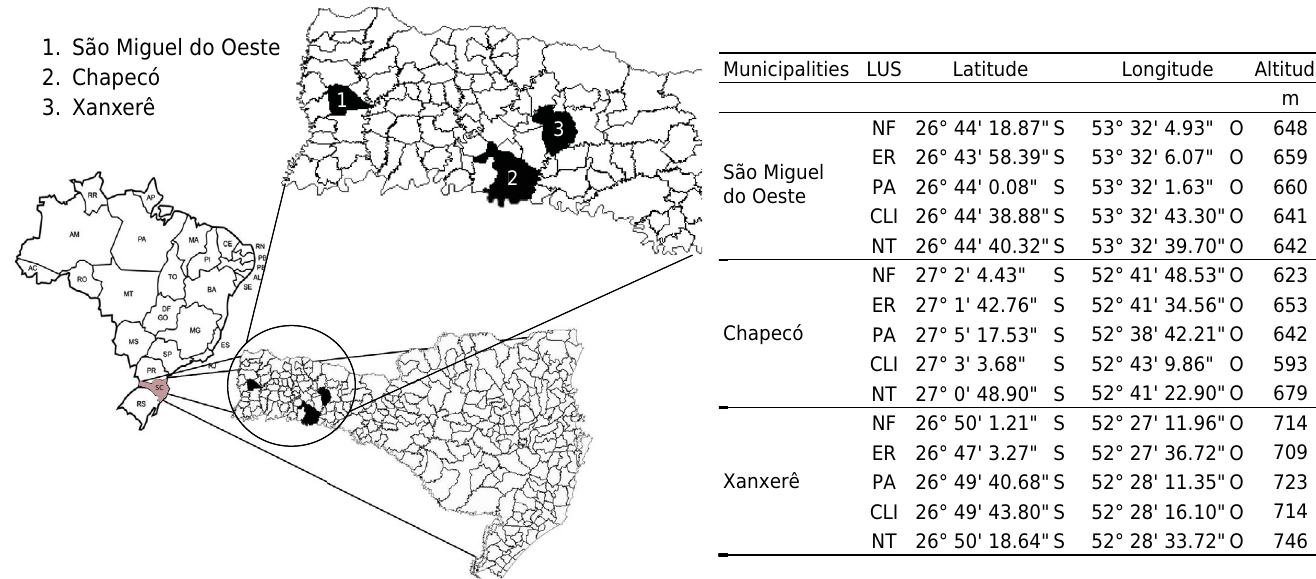
Figure 1. Geographic location and mean altitude of the land use system (LUS) of native forest (NF), eucalyptus reforestation (ER), pasture (PA), crop and livestock integration (CLI), and no-tillage (NT) in the municipalities of São Miguel do Oeste, Chapecó, and Xanxerê, in the western region of Santa